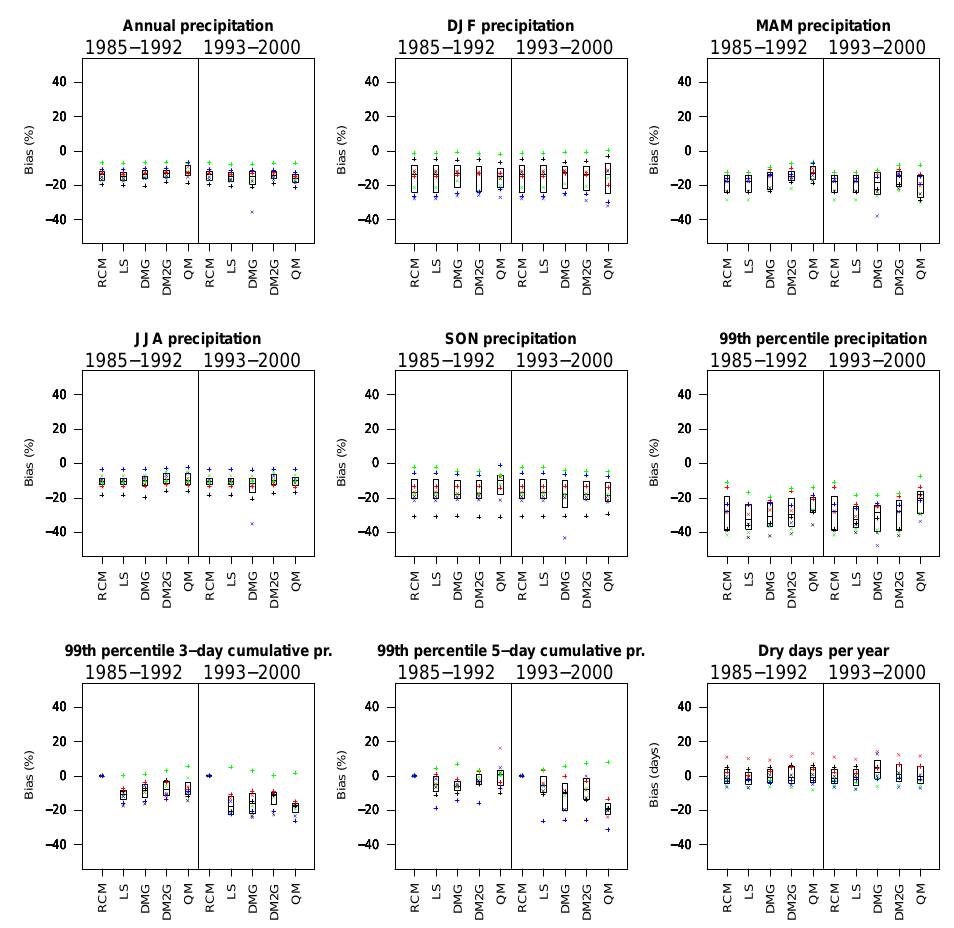
Figure 6. Differences between RCM simulations and observations in change signals in precipitation characteristics between periods 1985– 1992 and 1993–2000. The left and right panels indicate the validation periods in each